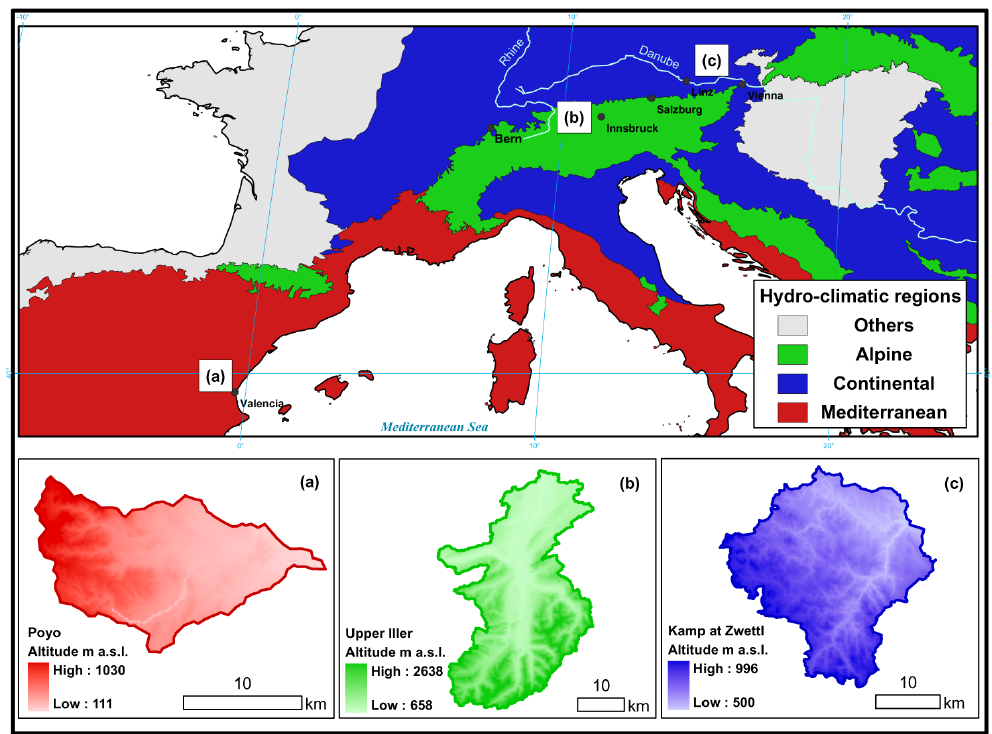
Fig. 1. Location of the studied catchments: (a) Poyo, (b) Upper Iller and (c) Kamp. Hydro-climatic regions adapted from European Biogeo- graphical regions map (Source: European Environment